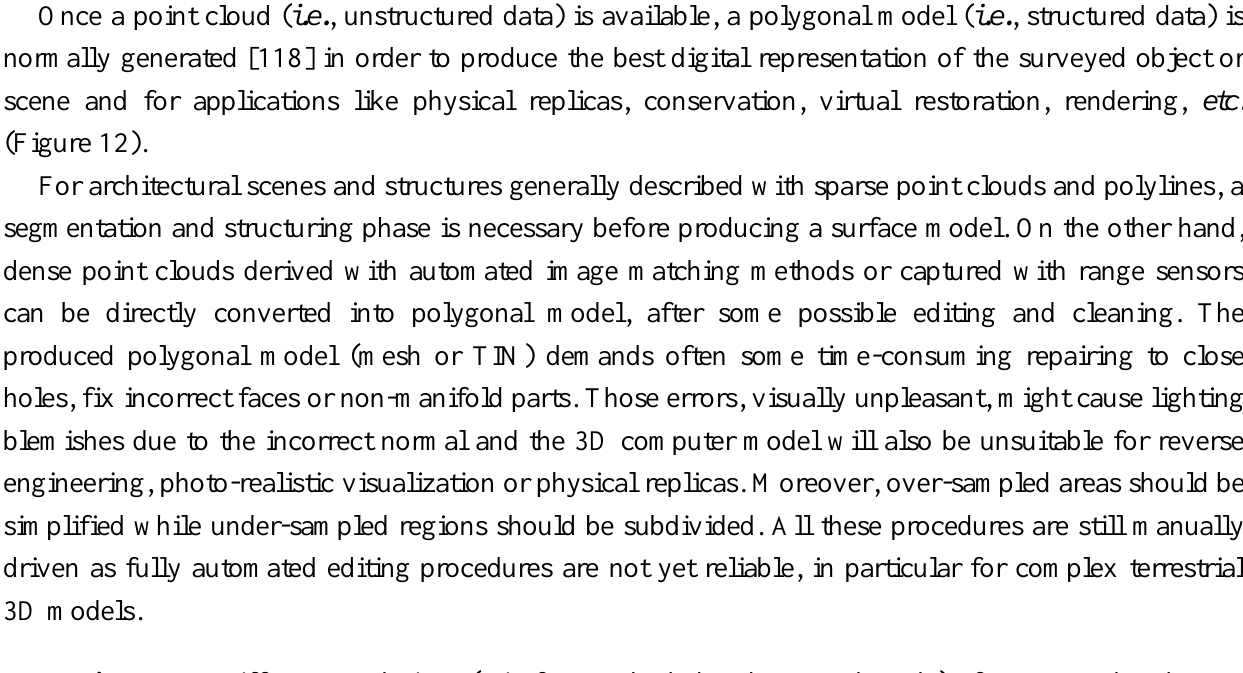
Figure 12. Different renderings (wireframe, shaded and textured mode) of a surveyed and modeled underground